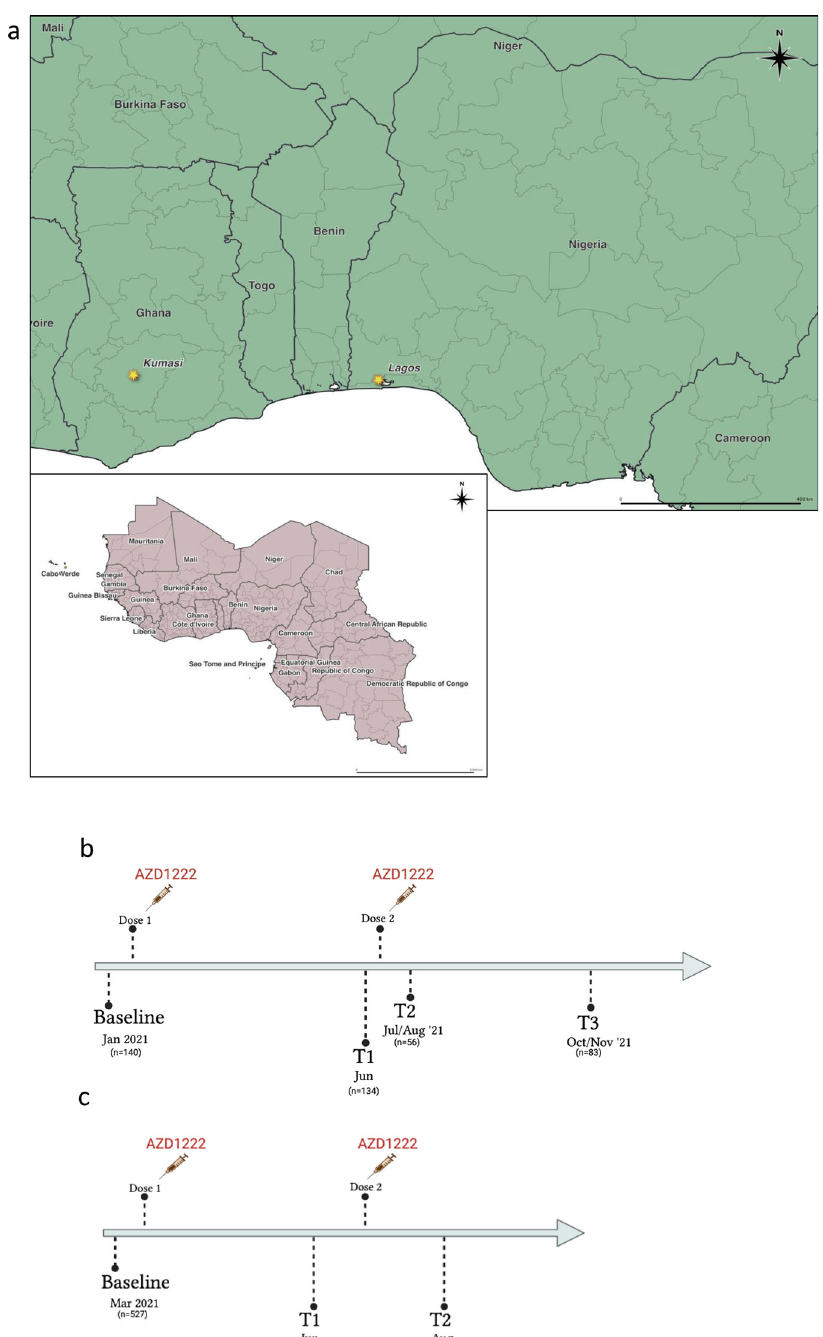
Fig. 1 | Study sites and design. a Map of Western Africa showing study sites in Ghana and Nigeria. Study design and fl ow of patient disposition for